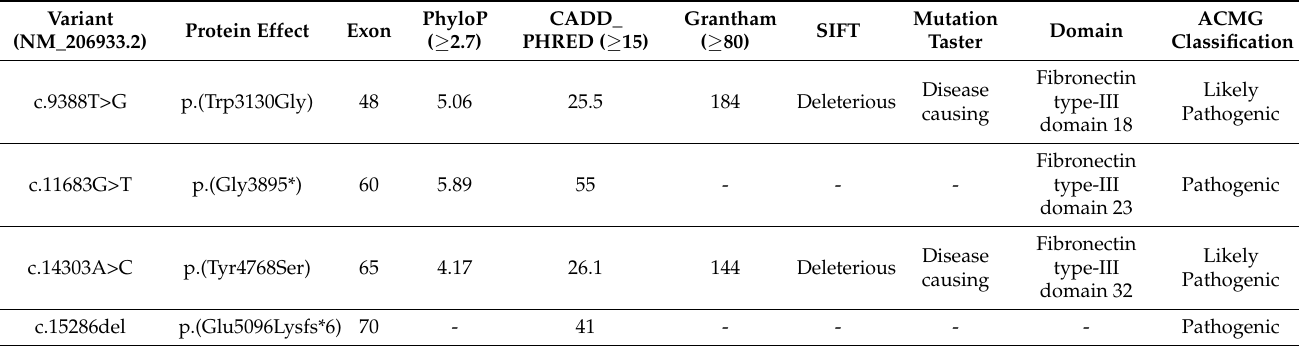
Table 1. Novel SNVs identified in this